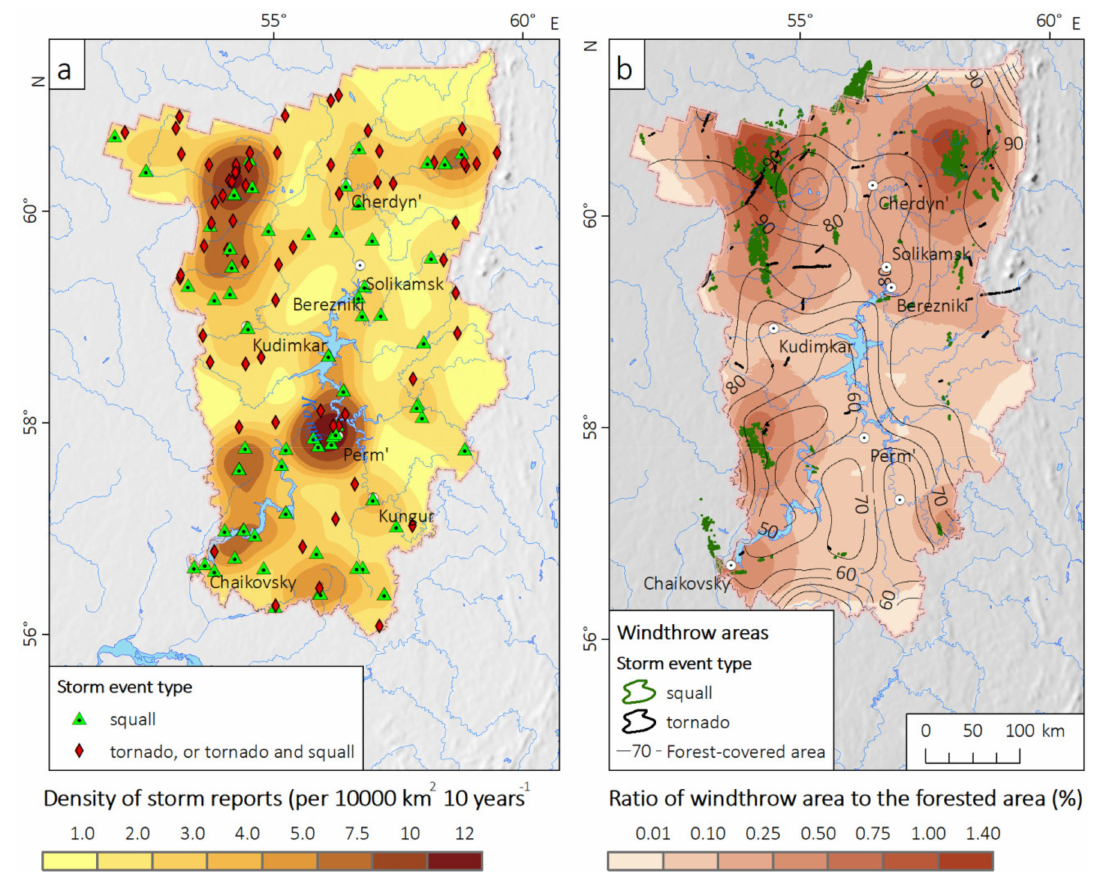
Figure 5. ( a ) Density of squall and tornado reports (number of reports per 10,000 km 2 year − 1 ), one point may indicate several nearly located storm reports with distance <50 km, and ( b ) ratio of the storm-damaged forested area to the total forested area. The density was calculated using the kernel density method implemented in the ArcGIS 10